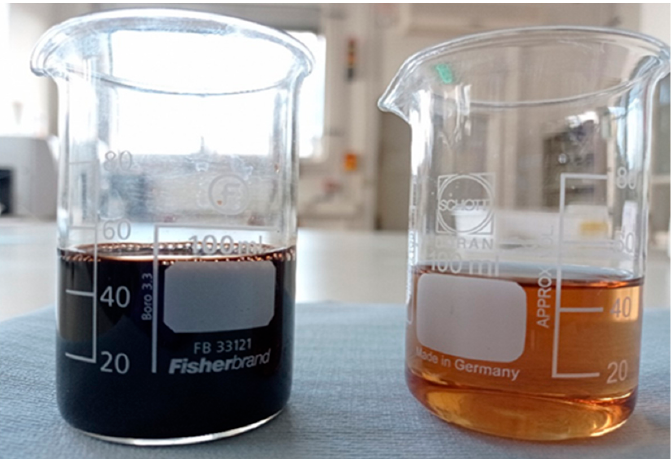
Figure 7. Black liquor-based feedstock, before SCWG (left ) after SCWG ( right ).